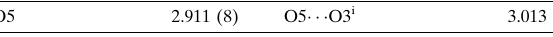
Selected interatomic distances (A˚ ).